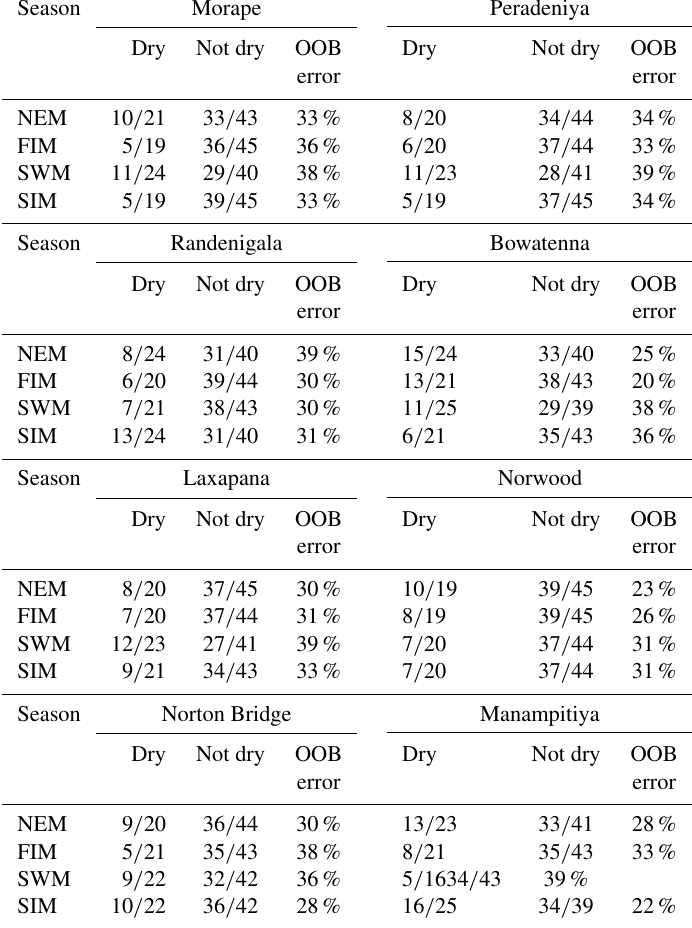
Table A7. Random forest model